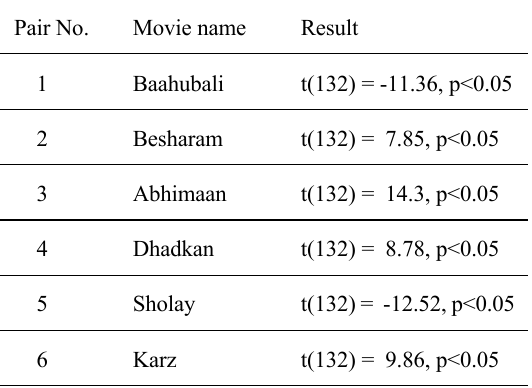
Table 4: Paired-samples t-test